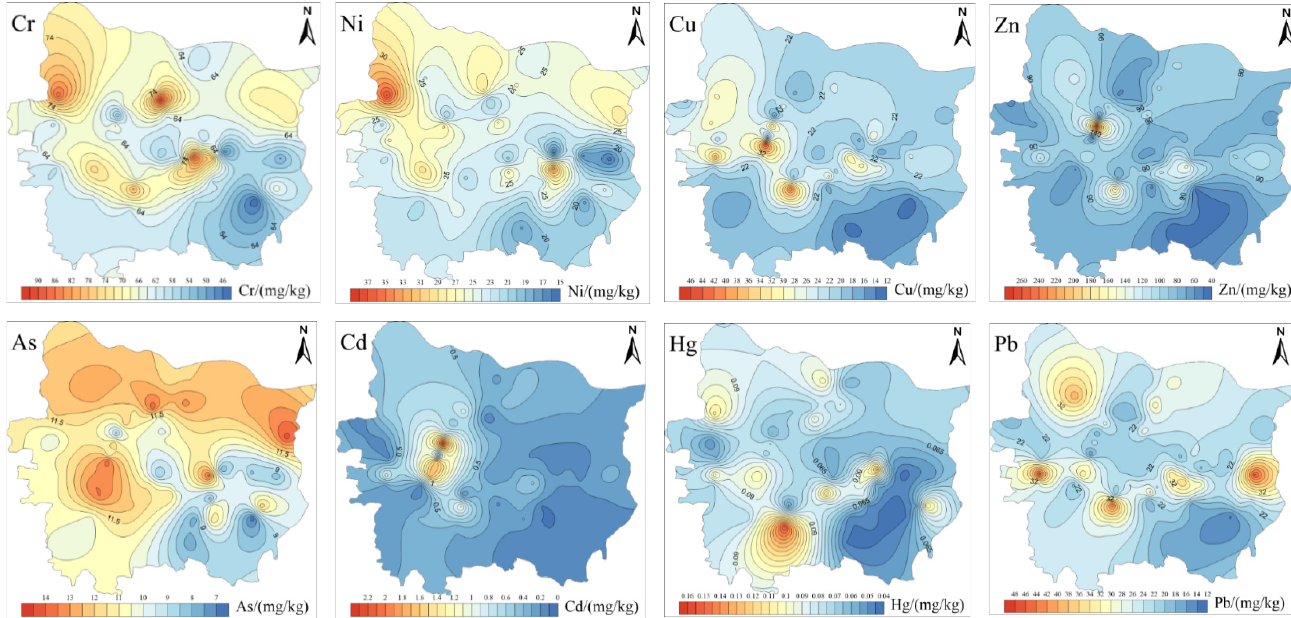
Figure 4. Spatial distribution of PTE concentrations in roadside soils of Zhengzhou.